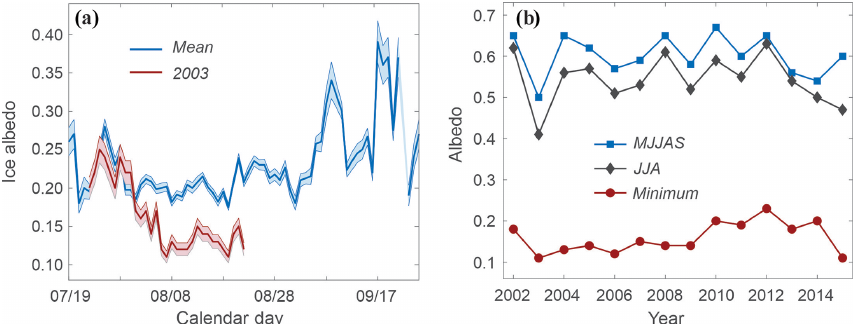
Figure 6. (a) Evolution of Haig Glacier ice albedo through the summer melt season. Mean values for 2002–2015 are shown in blue, and available data from summer 2003 are in red. In 2003, the station was leaning too much for reliable data after 23 August. Shading indicates the uncertainty envelope of the measurements (1 standard error). (b) Evolution of the mean melt-season albedo at Haig Glacier from 2002 to 2015, for May through September and July through August as well as the minimum daily value of each year.